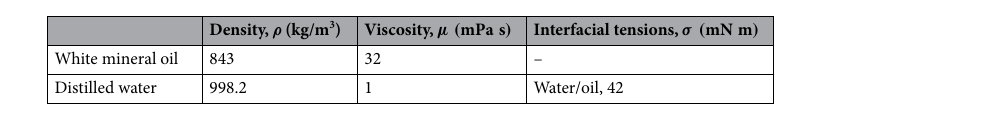
Table 1. Properties of water and oil phases measured at atmospheric pressure and 20